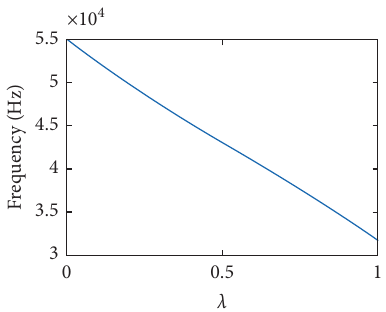
Figure 11: Relationship between natural frequency and wall thickness